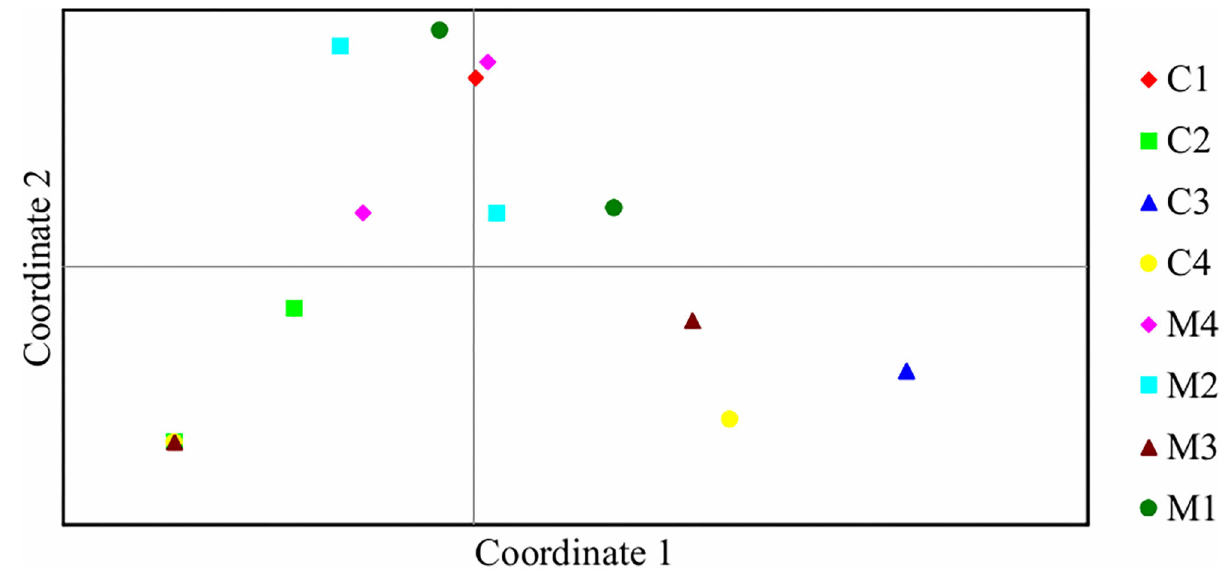
FIGURE 4 | Principal coordinate analysis of 15 bacteria isolates based on ARDRA restriction patterns. Percentage of variation explained by the first two coordinates; 1, 32.71%; 2,